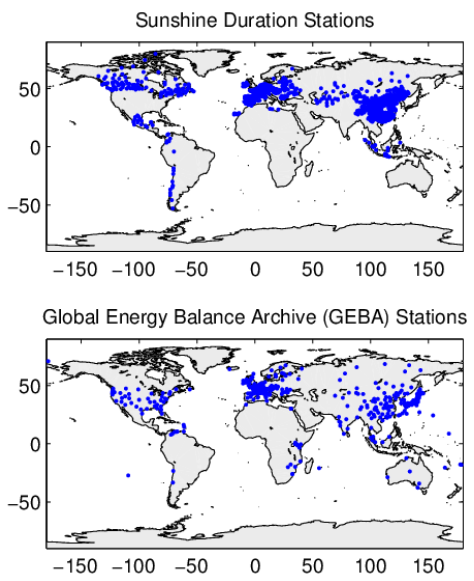
Fig. 1. A map of the Global Energy Balance Archive (GEBA) and Sunshine Duration (SunDu) stations. SunDu data are from the National Climate Data Center (NCDC) Integrated Surface Hourly Database and Chinese SunDu data are obtained from the Chinese Meteorological Administration. Each point in upper pannel represents a SunDu station where more than 120 months of data of SunDu are available (1165 stations in total). Considering the data availability, we divided the stations into six geographic regions: Europe (35–65 ◦ N, 10 ◦ W–40 ◦ E), Iran (20–50 ◦ N, 30–55 ◦ E), Indone- sia (20 ◦ S–20 ◦ N, 65–130 ◦ E), China (20–55 ◦ N, 55–150 ◦ E), North America (primarily Canada and Mexico, 15–65 ◦ N, 160–60 ◦ W), and Chile (60 ◦ S–15 ◦ N, 90–35 ◦ W). The number of stations in the regions are 373 (Europe), 26 (Iran), 417 (China), 75 (Indonesia), 119 (Canada and Mexico), and 26 (Chile).